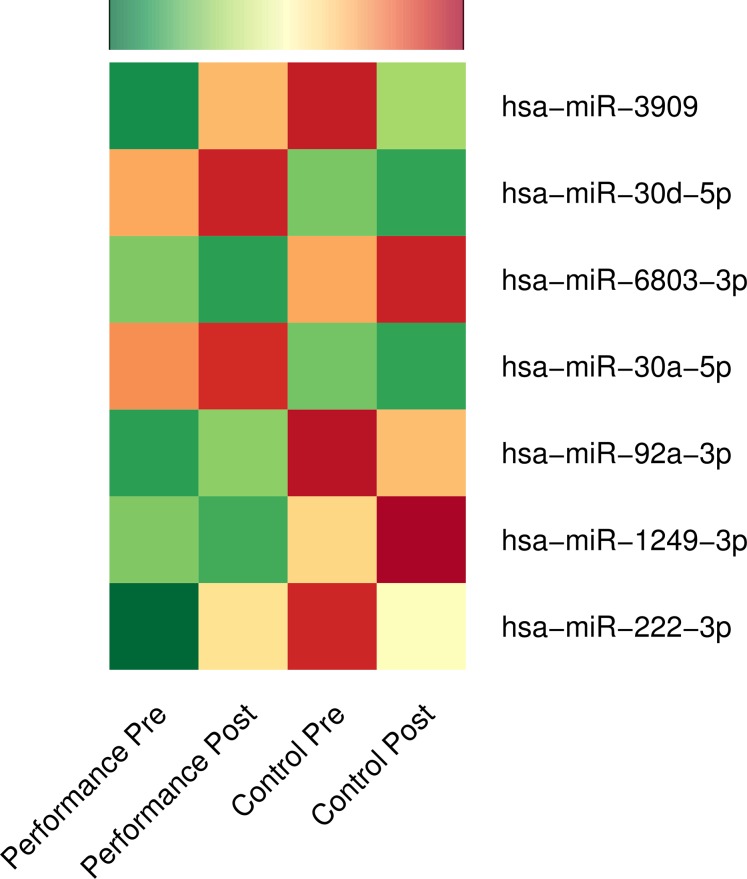
Differential expression of microRNAs: music-performance vs. controls.Normalised mean expressions of differentially regulated microRNAs before and after music-performance/control studies are represented using heatmap. Green, yellow and red colours denote low, moderate and high expression of microRNAs, respectively.